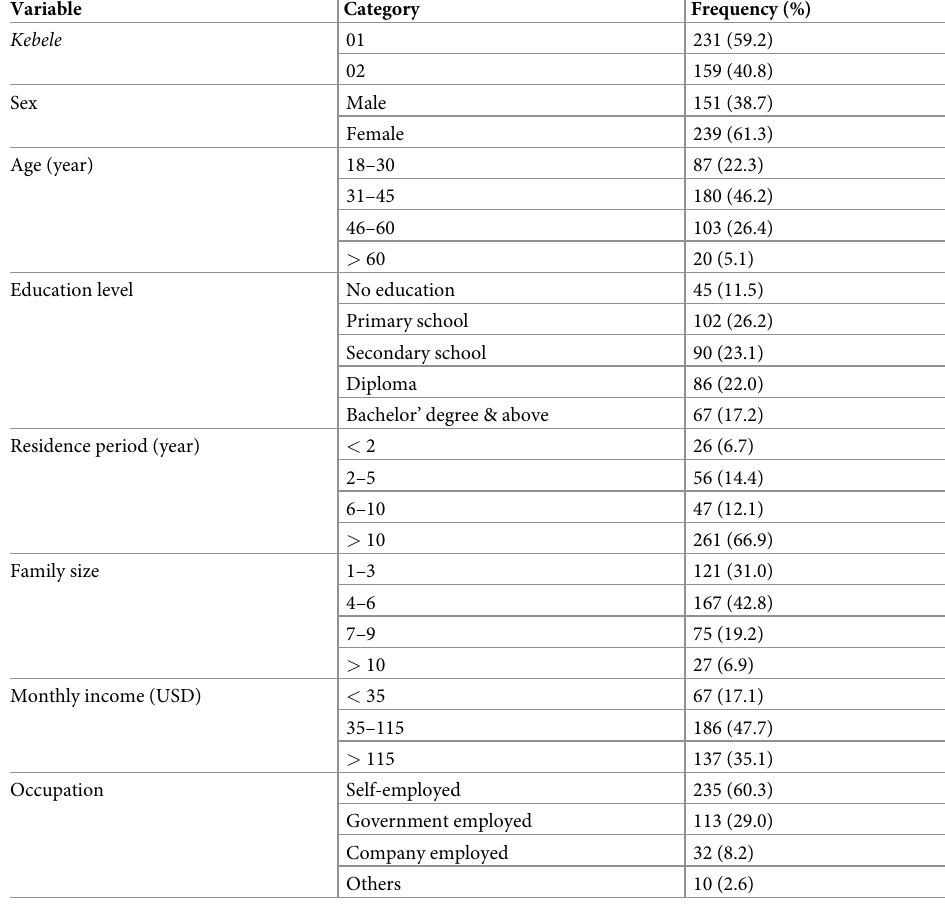
Table 1. Socio-demographic characteristic of the